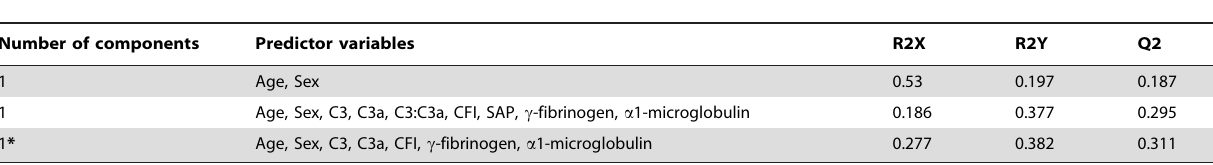
Table 4. Summary of the partial least squares (PLS) models fitted to whole brain volume in AD; R2X-variance explained in the predictor variables; R2Y-variance explained in the response variable i.e. whole brain volume; Q2-goodness of prediction of the PLS